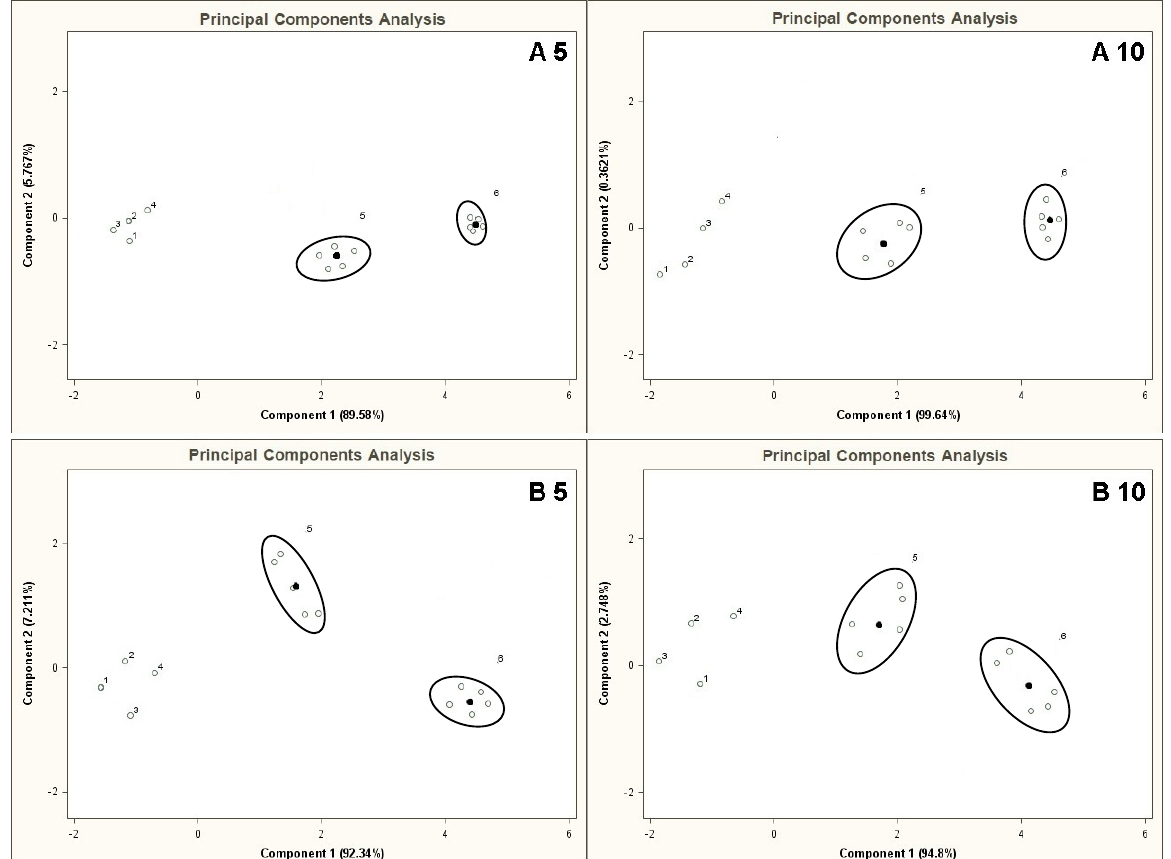
Figure 10. Result of PCA for the mixtures of type A 5 , B 5 , A 10 , B 10 where the points for the mixtures 5 and 6 represent mean values surrounded by a single result. Measurement was obtained for time instant 60